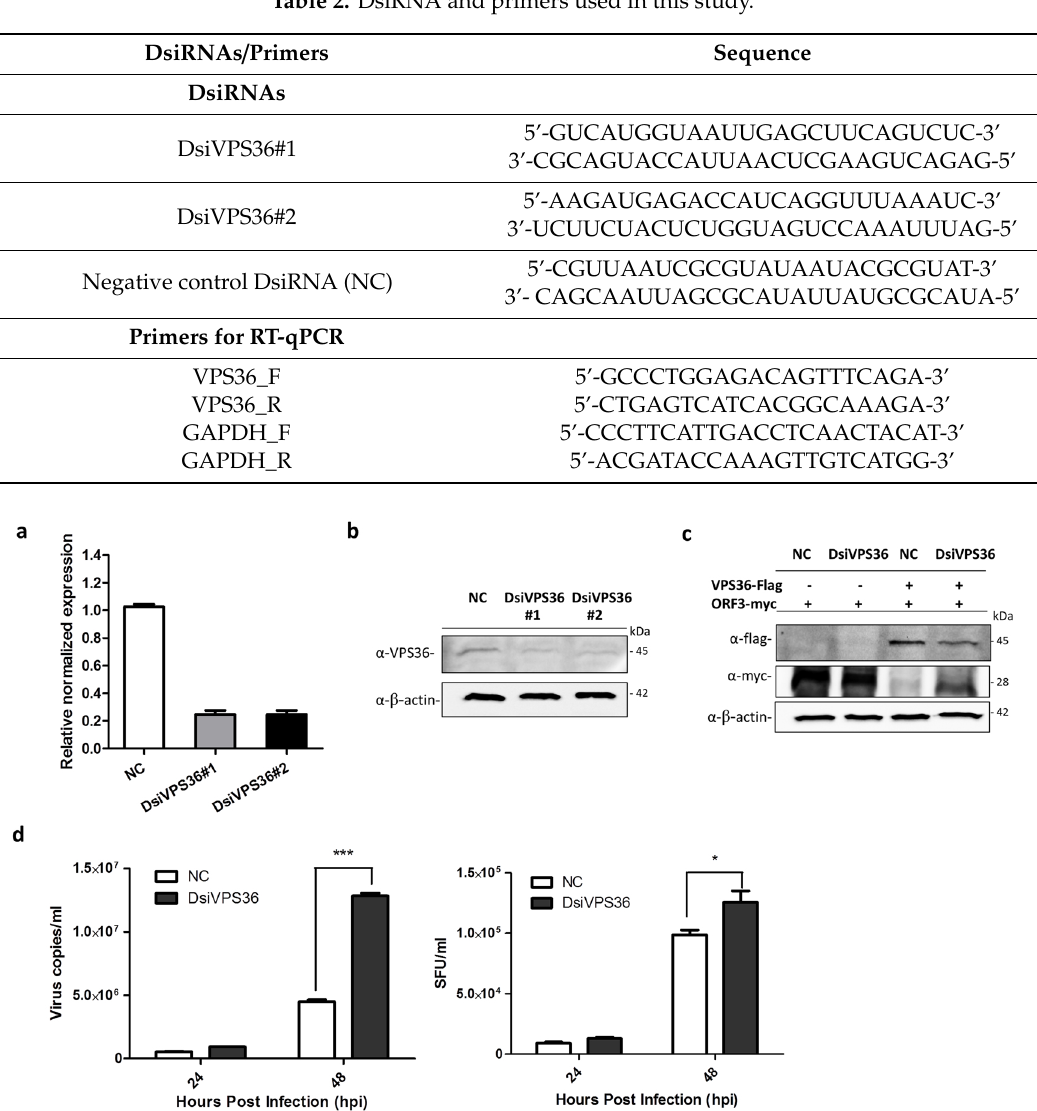
Figure 6. Silencing of VPS36 by DsiRNAs (DsiVPS36s). VeroE6-APN cells were transfected with each DsiVPS36 at a concentration of 40 nM. DsiRNA (NC) was used as negative control. At 48 hpt, two DsiRNAs targeting VPS36 were examined for their silencing activity by ( a ) RT-qPCR and ( b ) western blot analysis. For RT-qPCR, relative mRNA expression of VPS36 was normalized with the internal control GAPDH. Error bars indicate mean ± SEM from duplicate experiments. For western blot, rabbit anti-VPS36 antibodies were used to detect endogenous VPS36. ( c ) Plasmids expressing VPS36flag and ORF3myc were co-transfected into VeroE6-APN cells. At 8 hpt, cells were transfected with DsiVPS36_1 or NC and further incubated for 48 h. Rabbit anti-flag and -myc antibodies were used to detect exogenous VPS36 and ORF3. β -actin was used as internal control. ( d ) PEDV AV12 _ORF3myc growth kinetics in VPS36 knock-down cells. VeroE6-APN cells were infected with PEDV AV12 _ORF3myc at MOI of 0.1 after transfection with DsiVPS36 for 48 h. Error bars indicate mean ± SEM. Cell supernatants were collected for virus quantification (virus copies / mL) and viral titer (SFU / mL) at indicated time points. *, p < 0.05, *** denotes p <